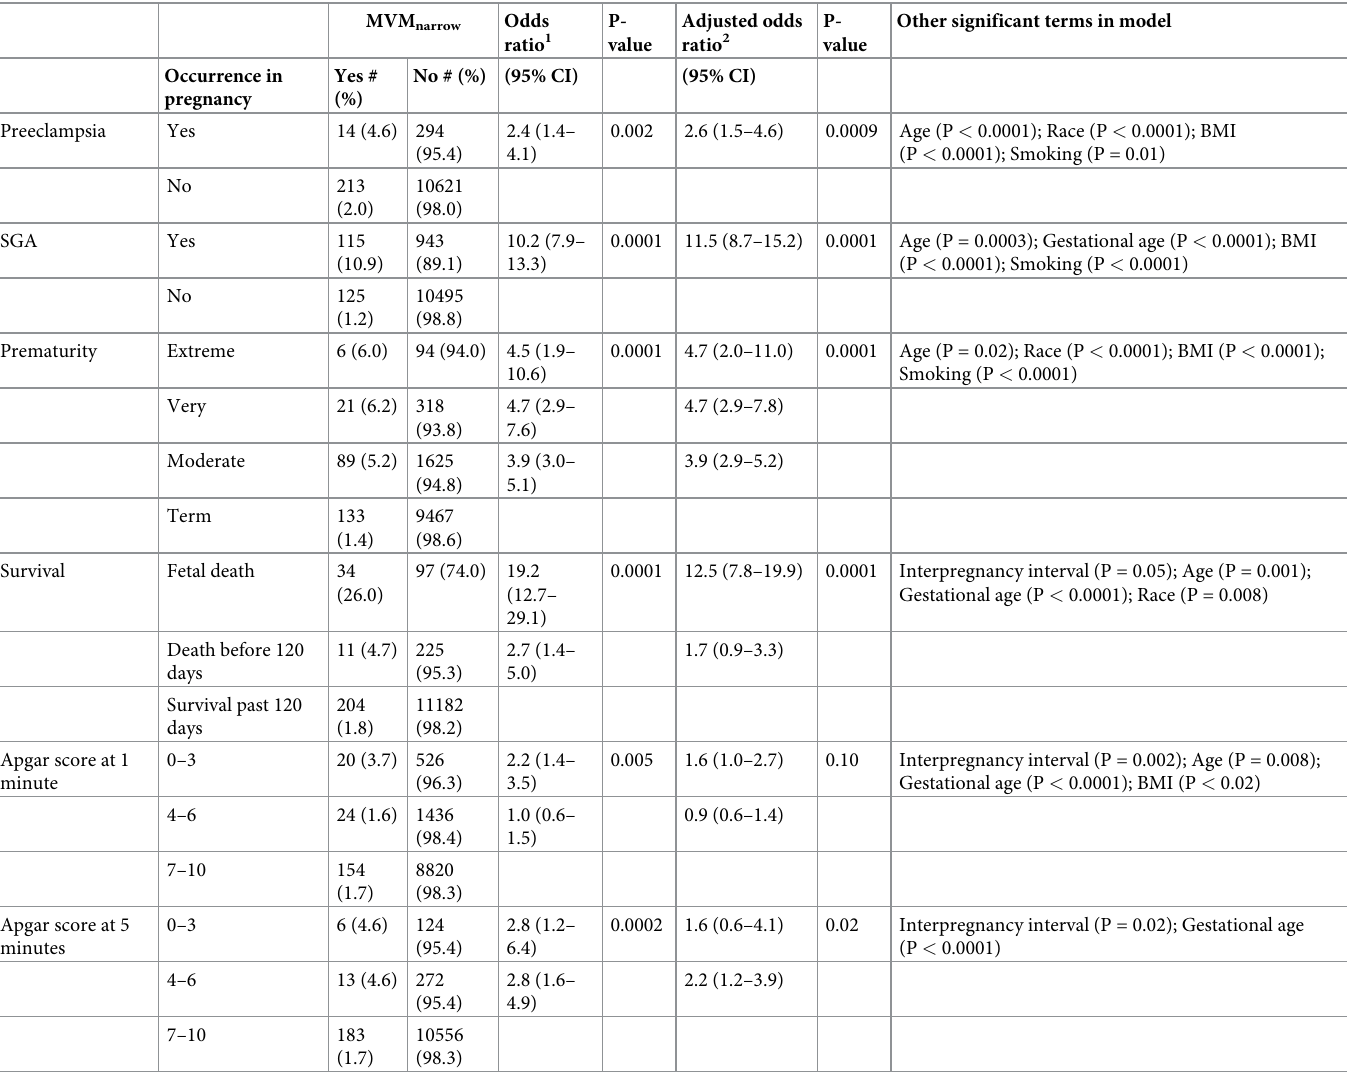
Table 4. Associations between MVM narrow lesions and pregnancy